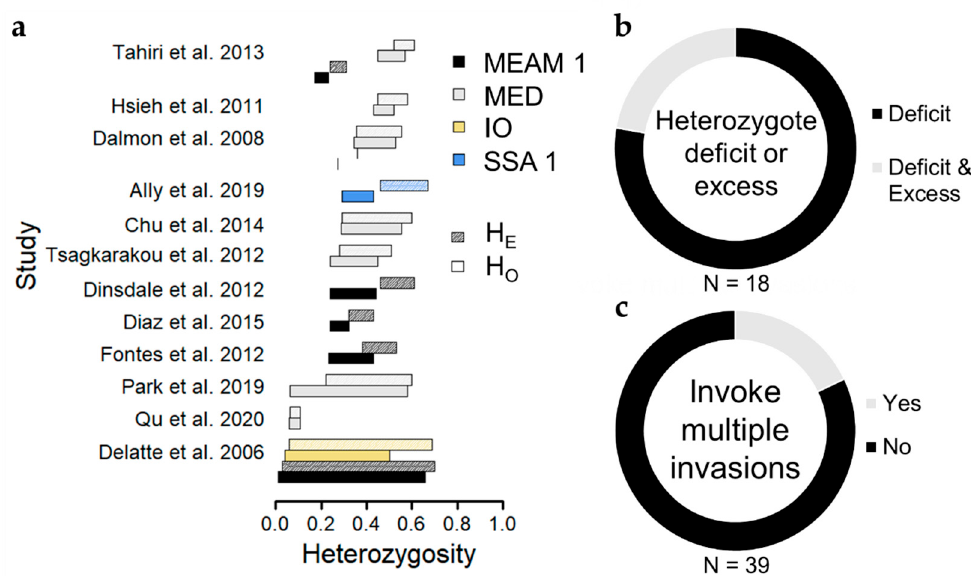
Figure 4. Summary of genetic diversity among populations within cryptic species among studies. ( a ) Barplots depicting the range of observed and expected heterozygosity for each cryptic species among studies [13,16,17,54,56–58,60,61,65,66,70]. “MEAM 1” stands for Middle East-Asia Minor 1; “MED” stands for Mediterranean; “IO” stands for Indian Ocean; “SSA 1” stands for Sub-Saharan Africa 1. ( b ) Circle diagram depicting the proportion of studies reporting heterozygote deficits (regardless of whether this was formally tested with a statistical model) among most if not all populations. ( c ) Circle diagram depicting the proportion of studies that interpreted patterns of genetic variation as evidence of multiple invasions having occurred in the study region.